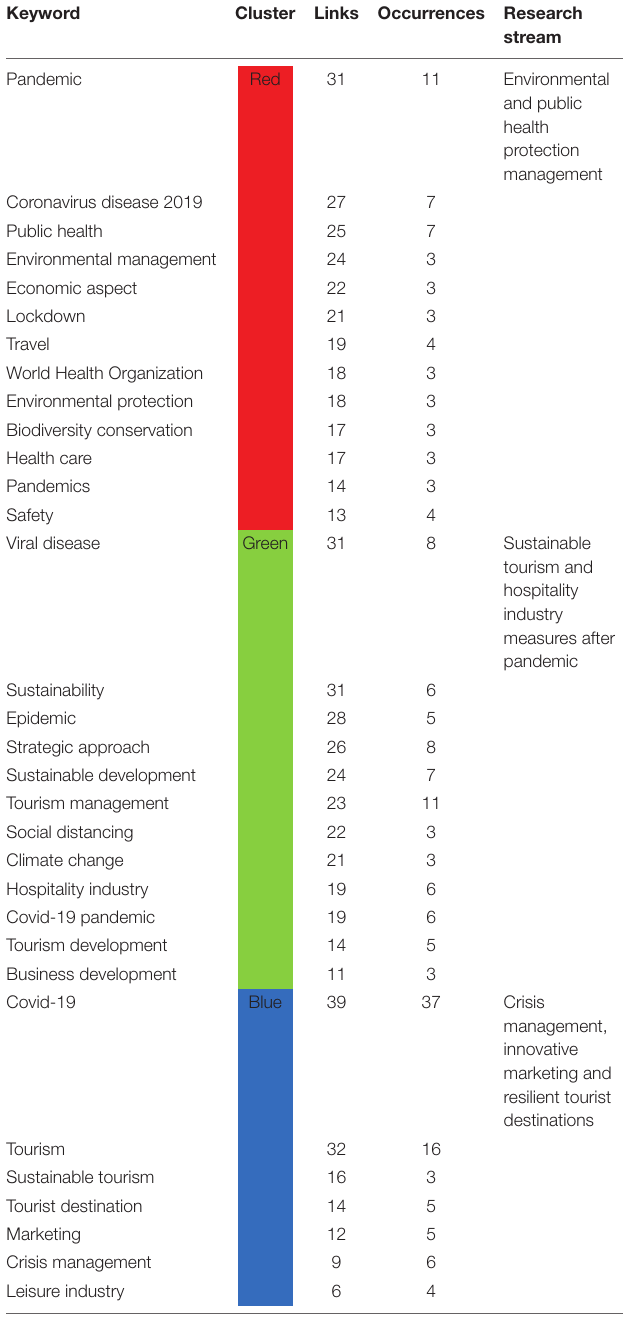
TABLE 12 | Holistic co-occurrence network with research streams.